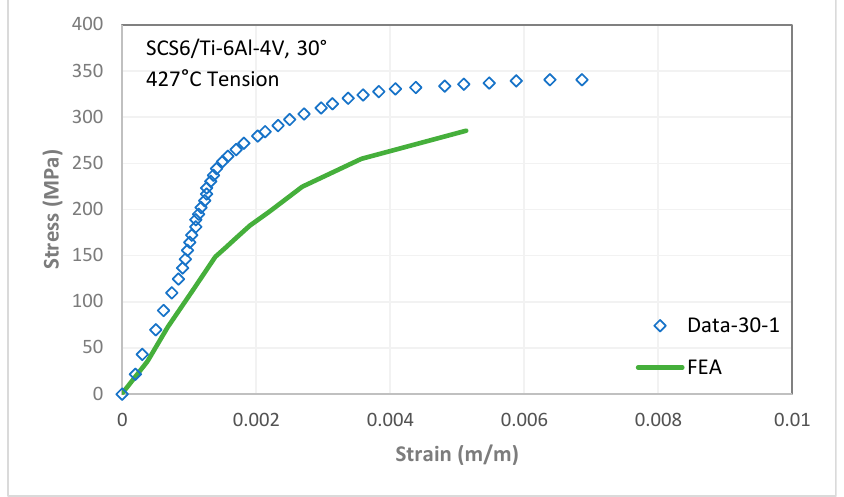
Figure 13. Stress-strain response for 30° off-axis at 427 °C. J. Compos. Sci. 2020 , 4 , x